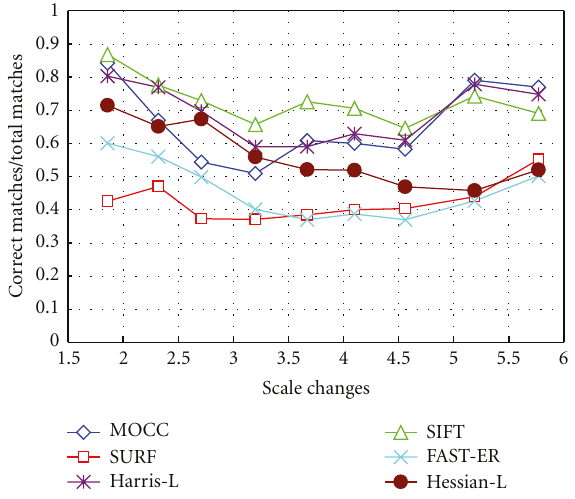
Figure 15: Precision comparison.